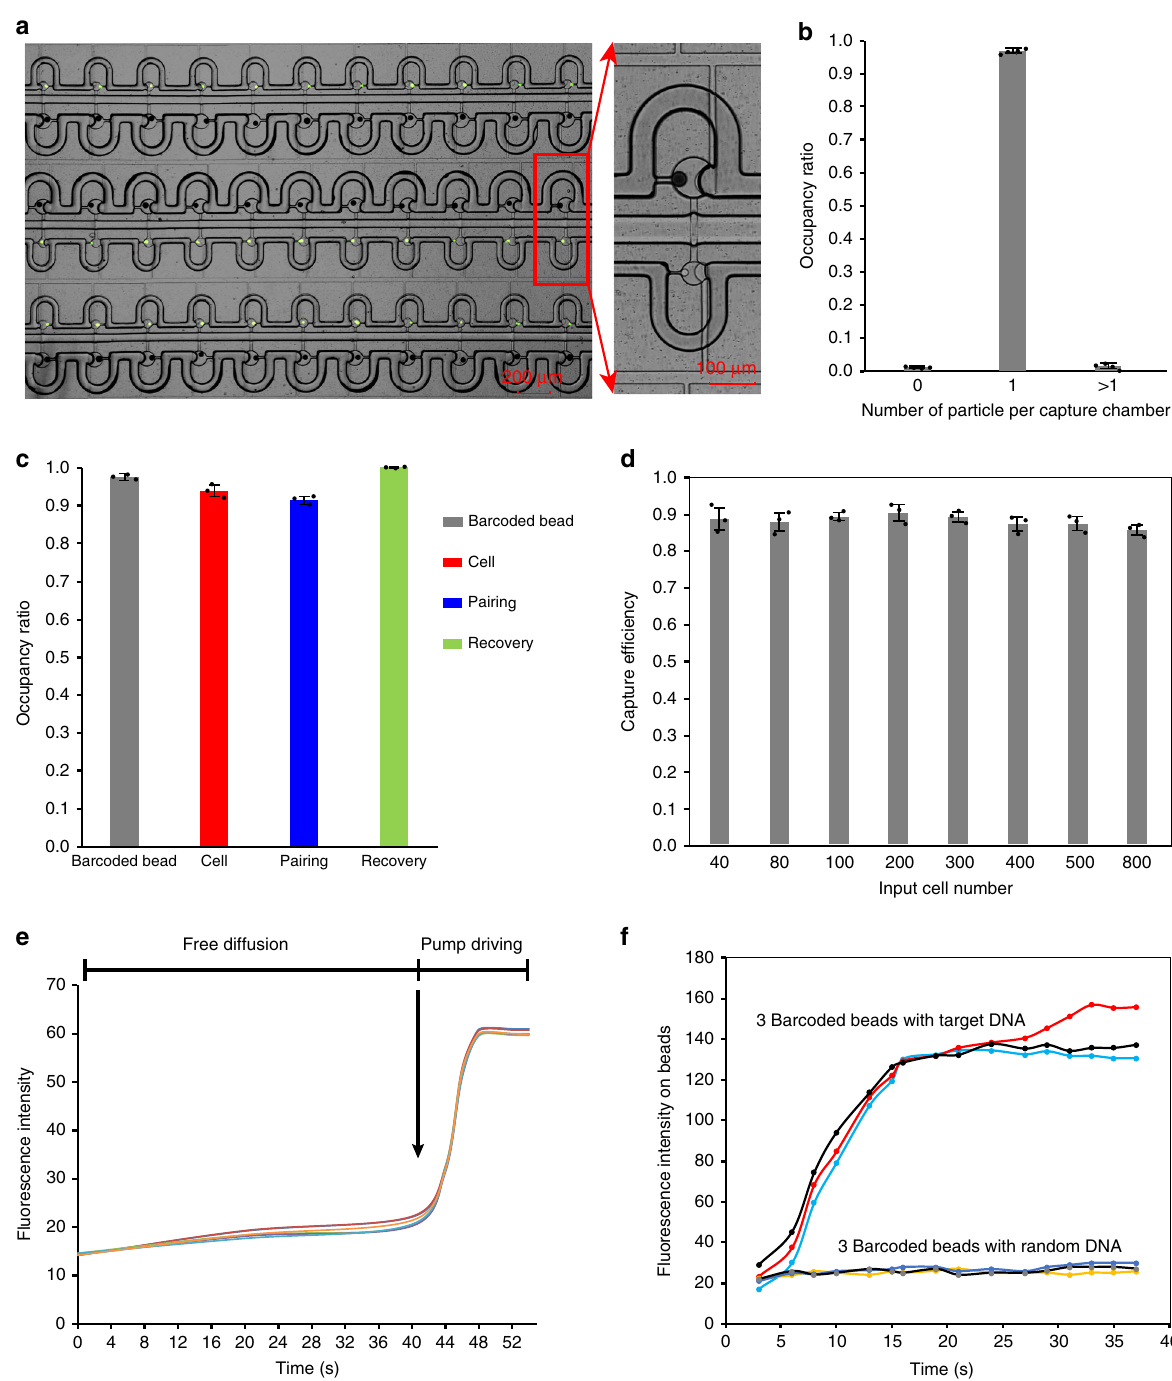
Fig. 3 Pro fi ling of Paired-seq chip. a Image of Paired-seq chip loaded with single cells and single beads, which were compartmented in water-in-gas droplets. b The occupation ratio of single particle in Paired-seq chip. Error bars, mean ± s.d., n = 4. c The statistical chart of bead and cell occupation ratio, pairing ratio and bead recovery ratio. Error bars, mean ± s.d., n = 3. d Single cell capture ef fi ciency with different numbers of input cells. Error bars, mean ± s.d., n = 3. e Change of cell chamber fl uorescence intensity indication mixing ef fi ciency of TAMRA dye solution in bead chamber with PBS in cell chamber under conditions of free diffusion and pump driving. f Characterization of DNA hybridization on the surface of barcoded beads with target DNA and random DNA. Source data are provided as a Source Data fi